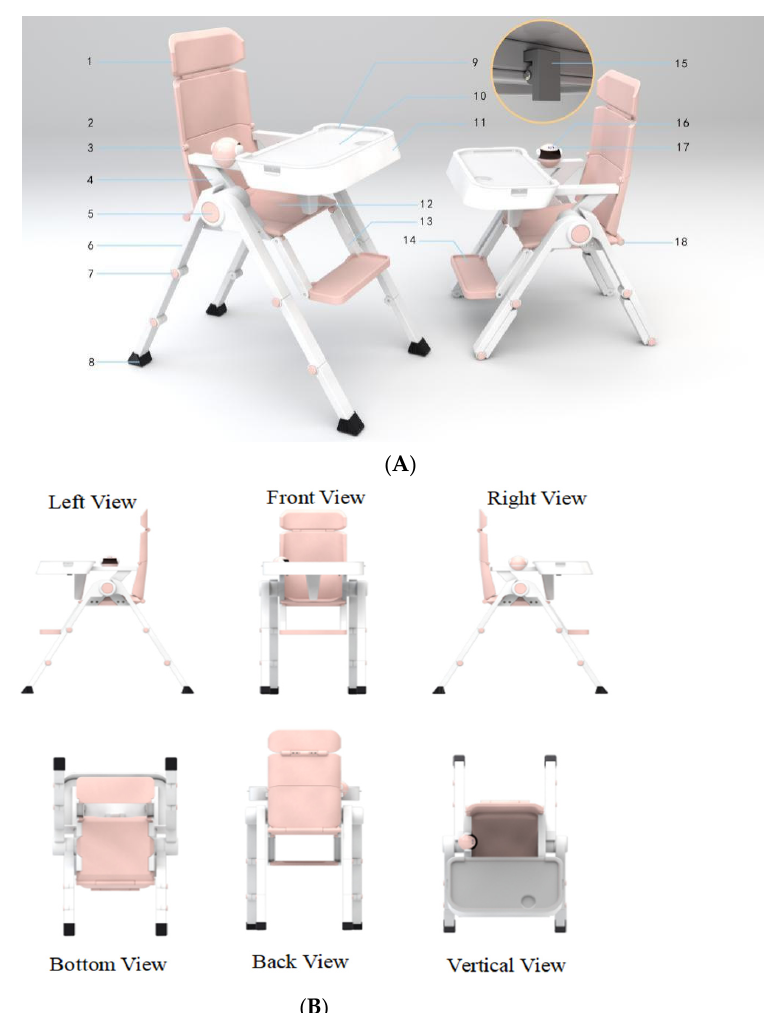
Figure 1. ( A ). Novel design of the multifunctional baby chair. 1. Backrest; 2. AI intelligence; 3. Backrest forward rotation button; 4. Armrest; 5. Support folding button; 6. Support leg; 7. Support rotation button; 8. Footpad; 9. Plate bacteria sensor; 10. Tray; 11. Dinner plate; 12. Seat; 13. Footrest rotating arm; 14. Footrest; 15. Moveable plate buckle; 16. Camera; 17. Infrared sensor; 18. Backrest adjustment button. ( B ). Six Views of the Baby Chair.